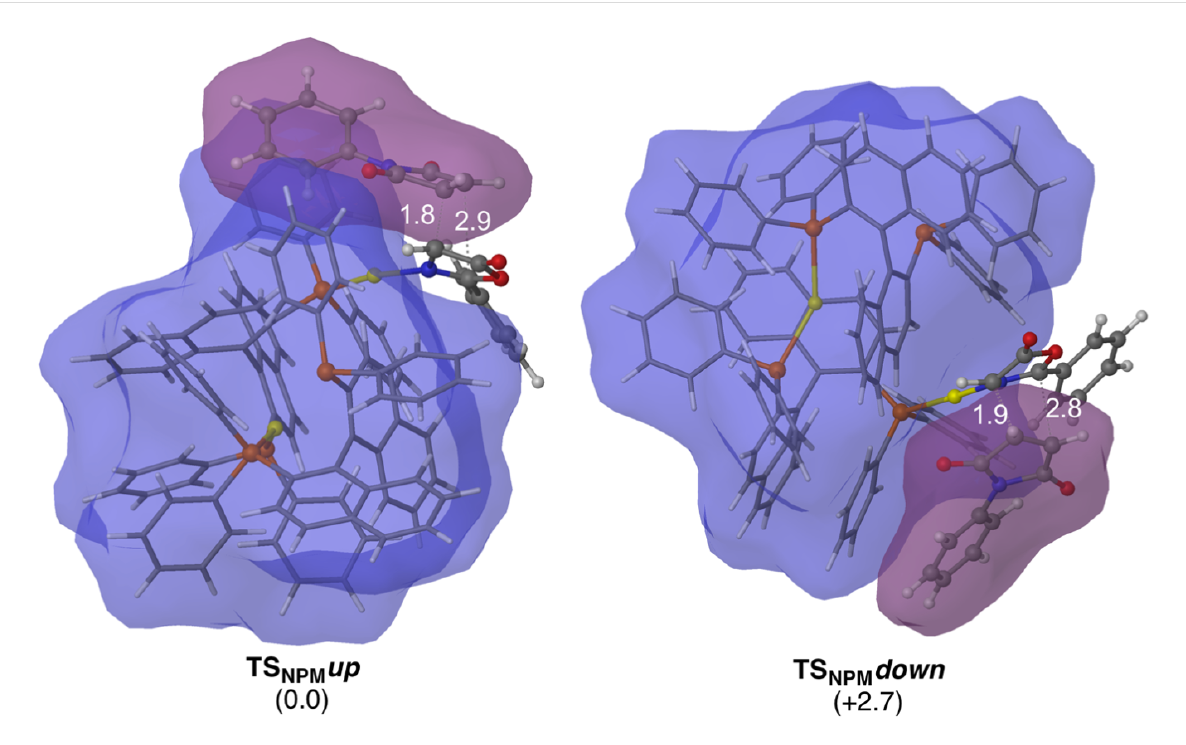
Figure 4: Main geometrical features and relative Gibbs free energies (in kcal mol − 1 ) of the less energetic transition states associated with the 1,3-DC of 5aa and NPM catalyzed by ( S a )-Binap gold dimers computed at M06/Lanl2dz//ONIOM(b3lyp/Lanl2dz:UFF) level of theory. High-level and low level layers are represented as ball and stick and wireframe models, respectively. Distances are in Å. Blue and purple surfaces represent the solvent- accessible surface of the catalyst and NPM with a probe radius of 1.9 Å.